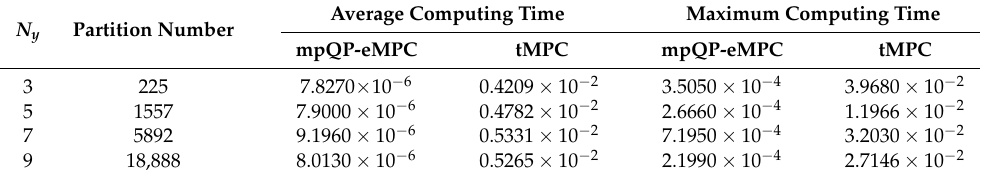
Figure 17. Speed response curves of gas turbine. Table 3. Real time verification